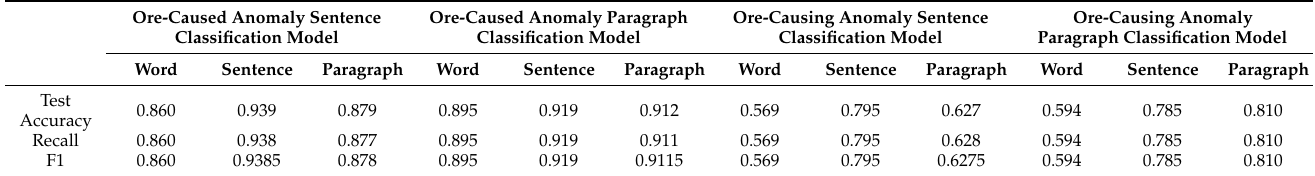
Table 4. Comparison table of evaluation indexes between sentence classification model and paragraph classification model.